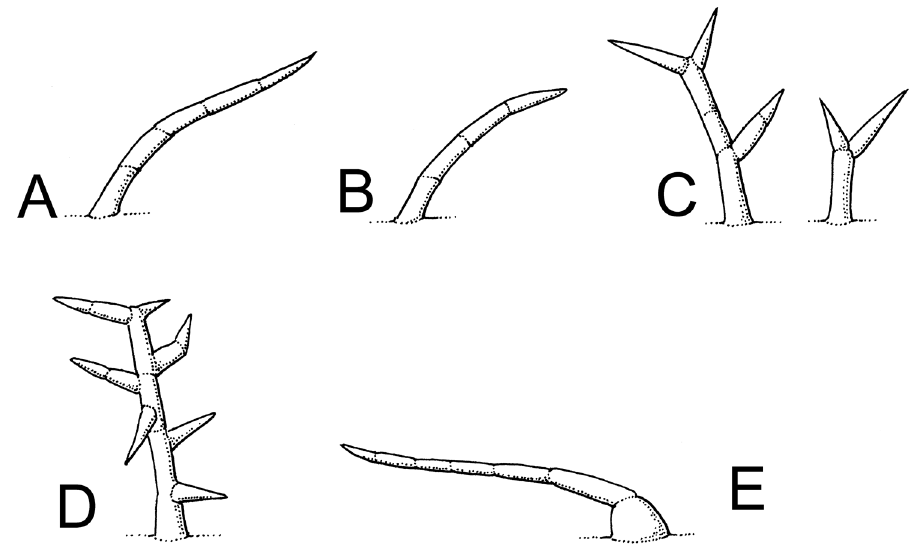
Figure 3. Trichome diversity in New Guinea Lycianthes A simple (unbranched) stiff, antrorse trichomes ( Streimann & Katik NGF-34091 ) B simple (unbranched) “crisped”trichomes ( Kalkmann BW-3479 ) C dendritic (antler-like) trichomes ( Streimann & Katik NGF-34091 ) D dendritic (Christmas-tree like) trichomes ( Wells NGF-7565 ) E simple (unbranched) stiff, antrorse trichomes with enlarged bases ( Millar NGF-40737 ). Drawing by Lucy